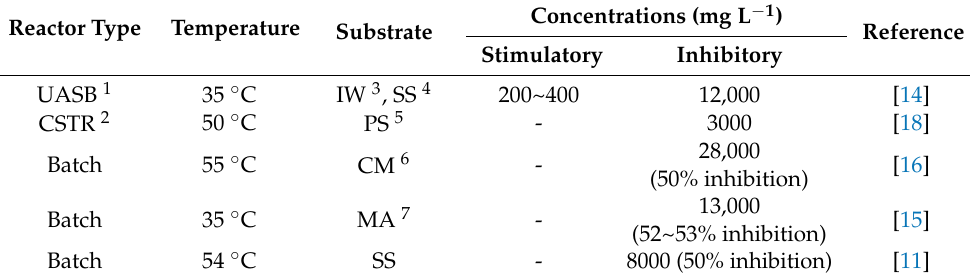
Figure 3. Effects of the water potential ( Ψ ) ( a ) and K + concentration ( b ) on the degree of inhibition of methane production from food wastewater. Table 8. Stimulatory and inhibitory concentrations of K + on anaerobic digestion.